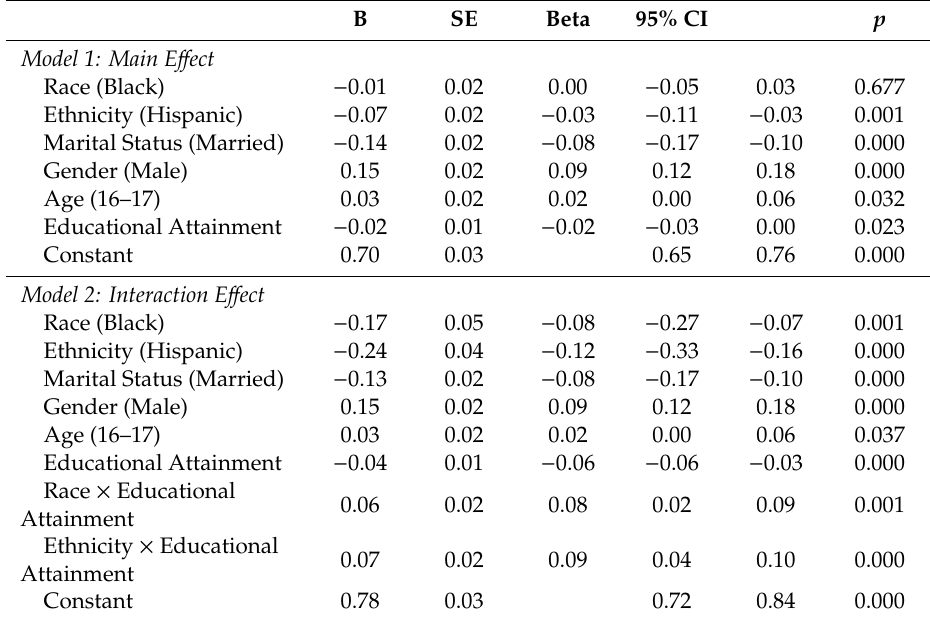
Table 3. Summary of linear regressions without and with interactions on the number of CMCs in the pooled